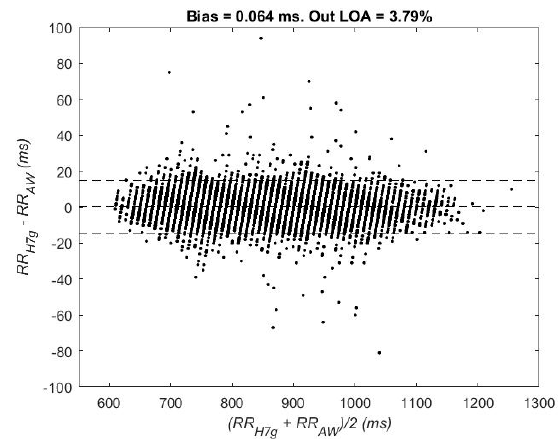
Figure 2. Bland-Altman plot: RR H 7 g vs. RR AW . Mean of the difference of the RR series ± 2*std values (limits of agreement, LOA).